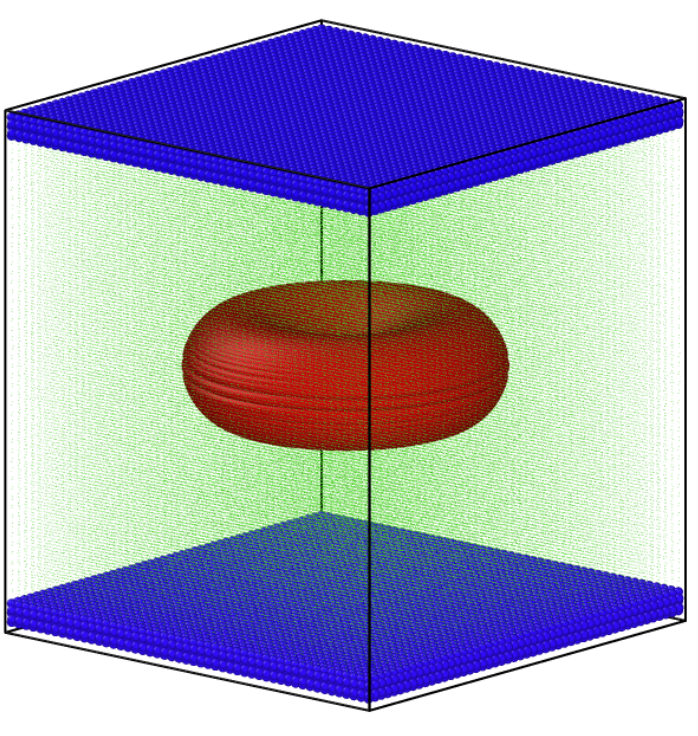
Figure 4. Computational domain for cell under shear rate; the RBC is illustrated by red particles, the top and bottom boundaries are blue, and the fluid particles are green (different particle size, particularly for green and red particles, is a post-processing trick for better illustration and has no further modelling or physical